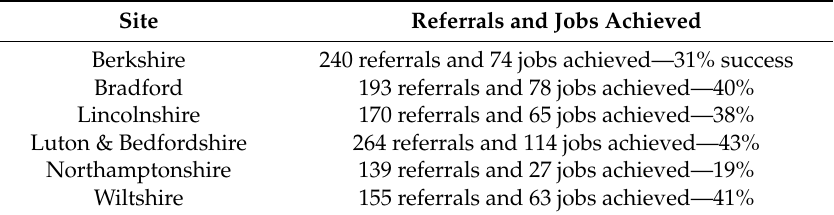
Table 3. Referrals and work outcomes in each